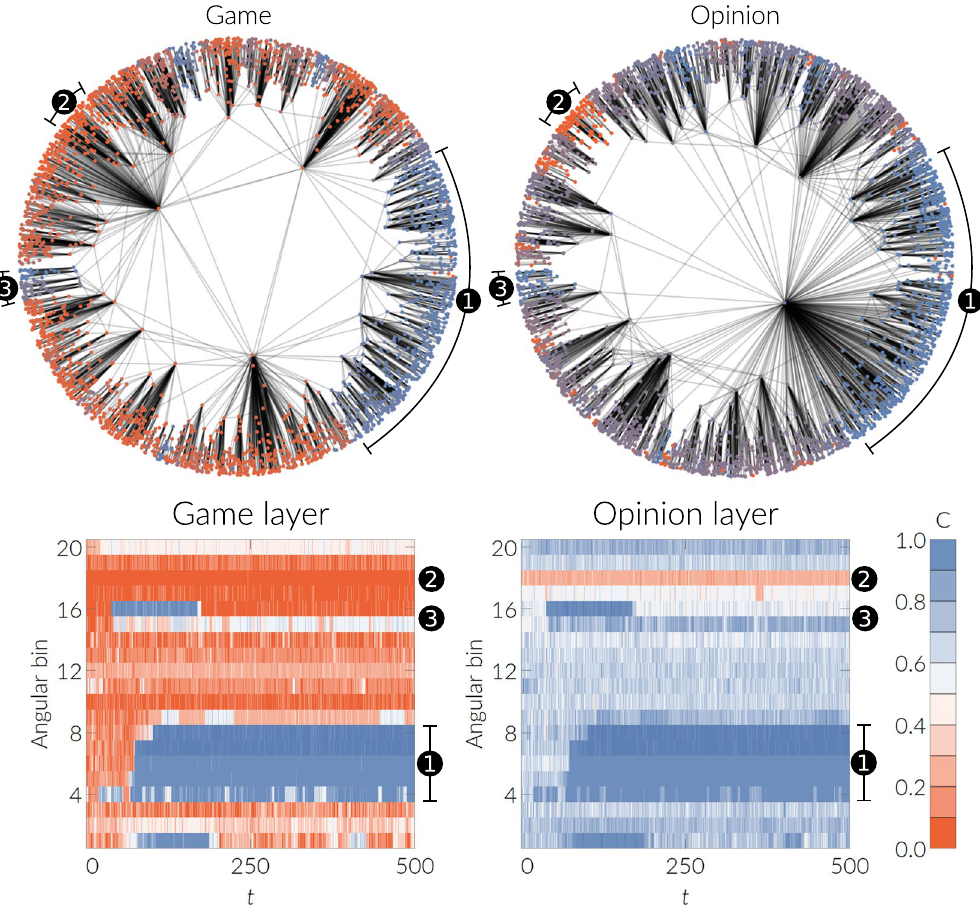
Figure 4. Polarization of the system in the presence of angular correlations between the layers ( g = 1, v = 0.2) for a multiplex with N = 5000 nodes, a power-law exponent 2.9, temperature 0.2, and mean degree 6 in both layers. Parameters of the game are T = 0.8 and S = − 0.4, the bias β is 0.7 and the coupling strength is 0.2. Results are for a single realization of our model starting with a density of cooperators of 0.1 in each layer. A visualization of this realization is shown in the Supplementary Video. The top row shows visualizations of the network layers. Color coded is the mean state of the each node, averaged over time. Each time step denotes 1000 update steps of each node. The bottom row shows the evolution of the density of cooperators in each angular bin. Numbers indicate selected clusters of nodes that tend to adopt the same strategy. Each timestep t denotes 10 3